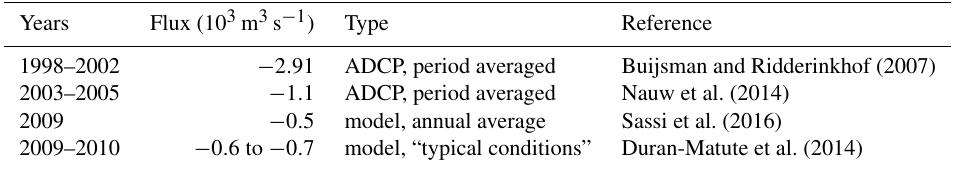
Table 1. Previously reported residual volume fluxes through the Marsdiep inlet.